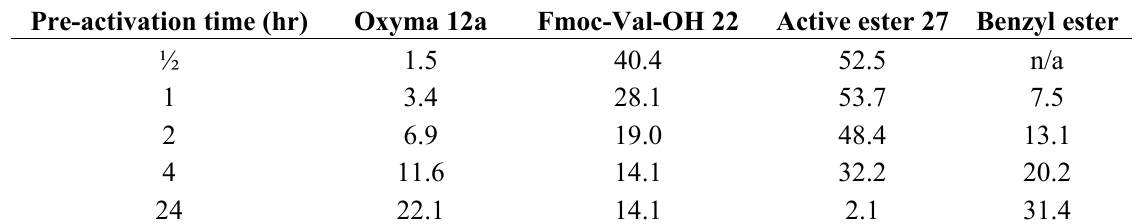
Table 7. The rate of formation of the active ester of Fmoc-Val-OH 22 using ethyl 2-(benzyloxycarbonyloxyimino)-2-cyanoacetate ( 19 ). Pre-activation time (hr)